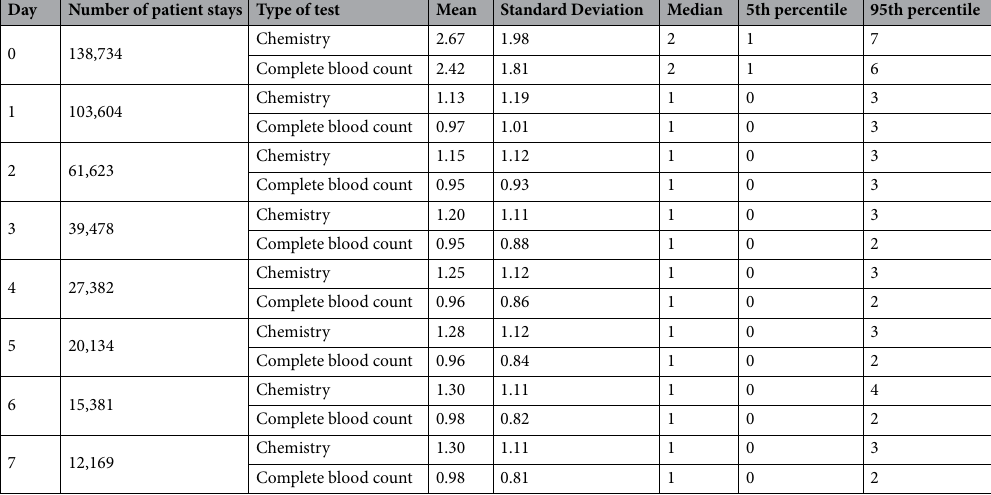
Table 2. Number of chemistry and complete blood count tests performed per patient per day during the first 8 days of intensive care unit stay.